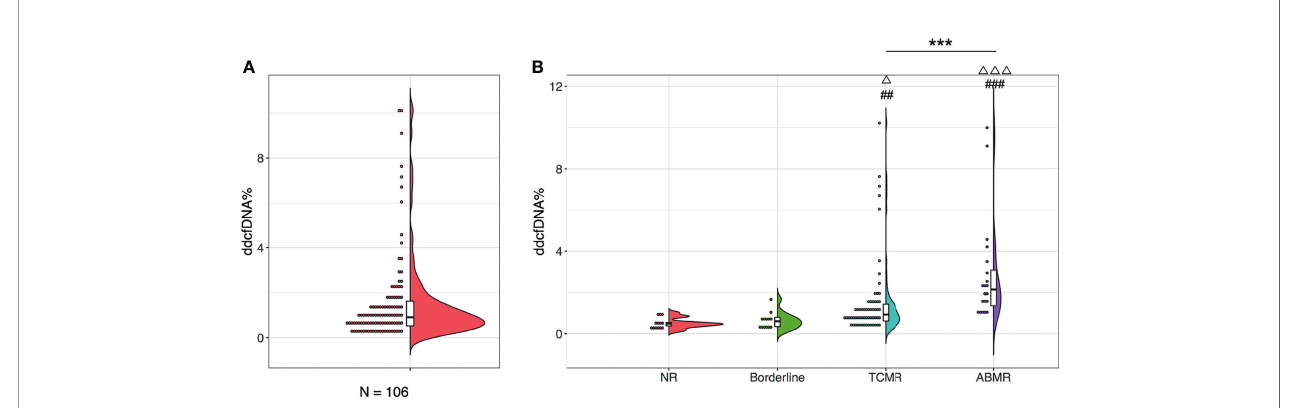
FIGURE 1 | Plasma ddcfDNA levels in kidney transplant recipients of different histopathologies. Distribution of plasma ddcfDNA fractions in total 106 patients enrolled (A) and in NR (n = 13), Borderline (n = 13), TCMR (n = 60), as well as ABMR (n = 20) subgroups with different histopathologies (B) . Raincloud plot with bold line represents median levels and box indicating the interquartile range. NR, no rejection; Borderline, borderline changes; TCMR, T cell-mediated rejection; ABMR, antibody- mediated rejection; ## P < 0.01 and ### P < 0.001 compared with the NR cohort; △ P < 0.05 and △△△ P < 0.001 compared with the borderline cohort. *** P <